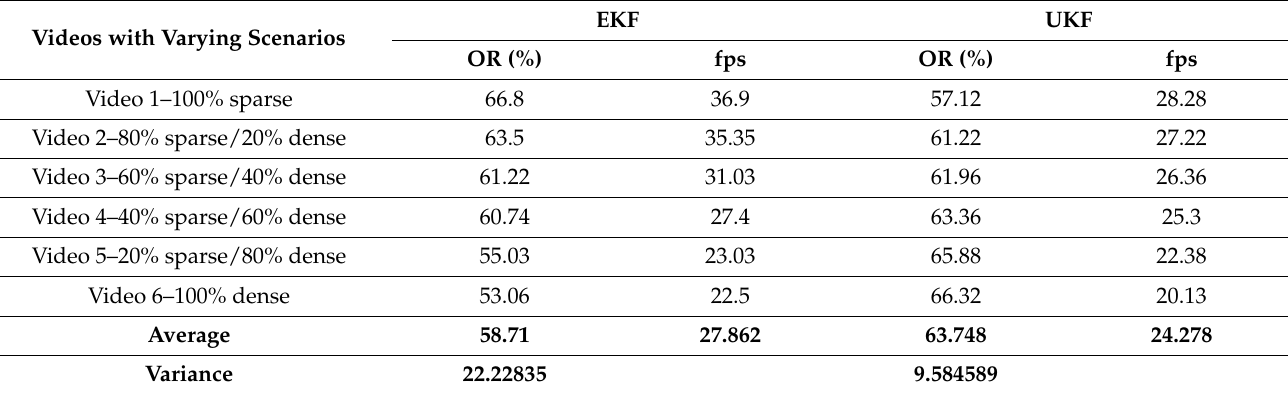
Table 3. Accuracy and execution time of fixed tracker fusion